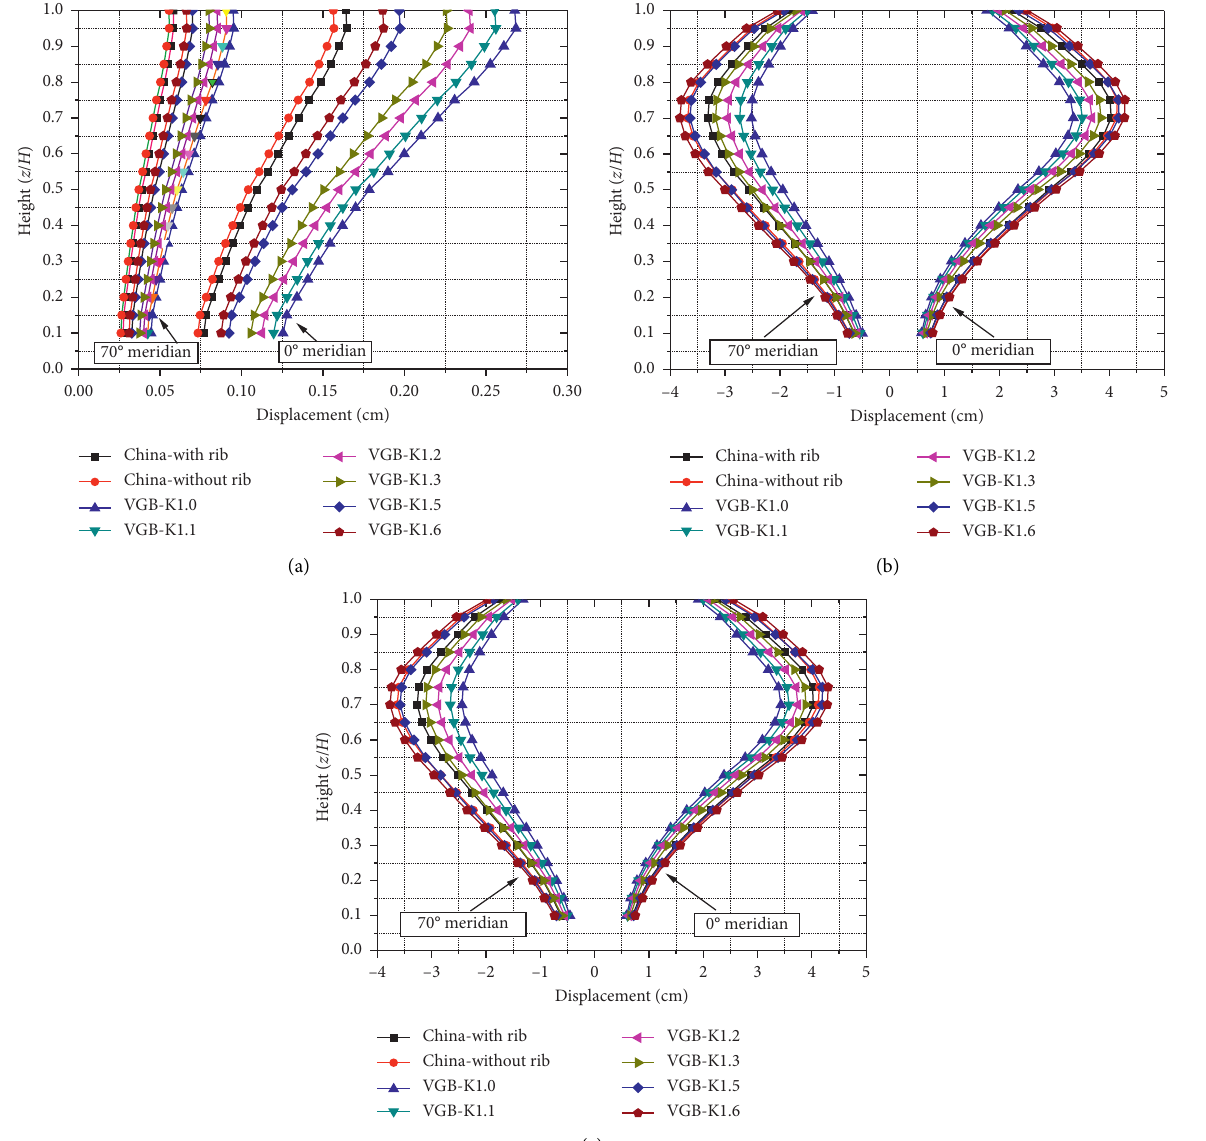
Figure 16: Total displacement and component for each component. (a) Displacement of the first-order harmonic component. (b) Displacement of DC and high-order harmonic components. (c) Total